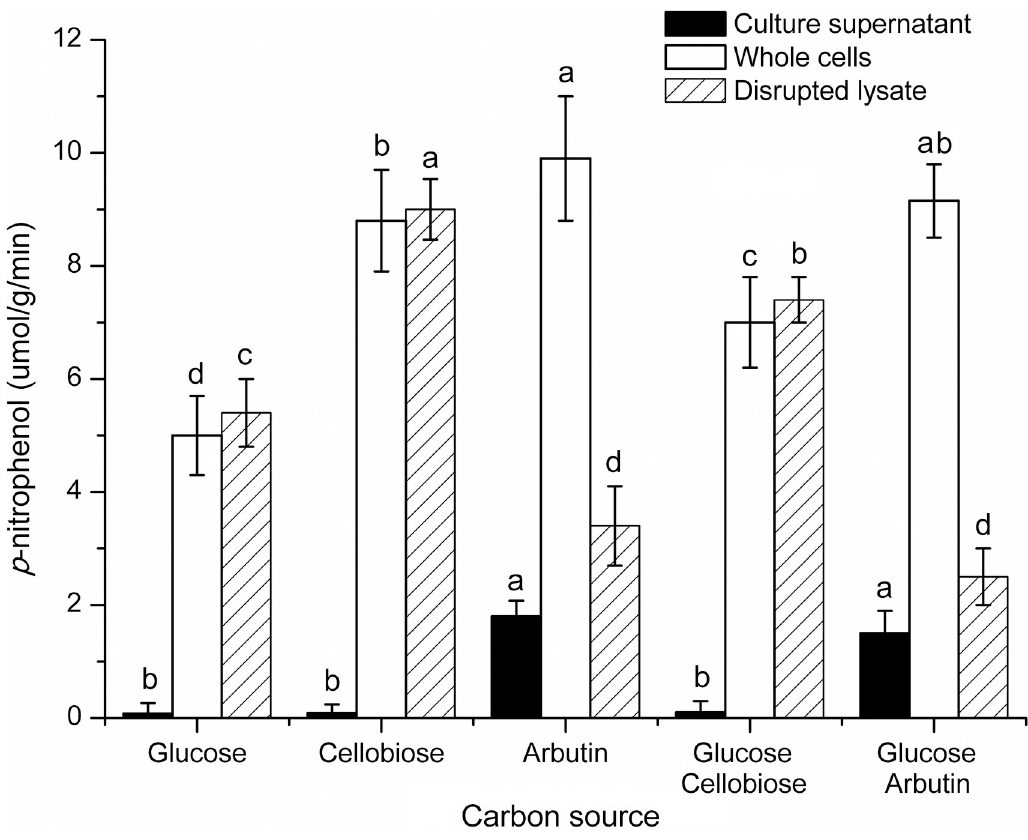
Fig 2. β -D-glucosidase activities of O . oeni SD-2a cultured with different carbon sources.